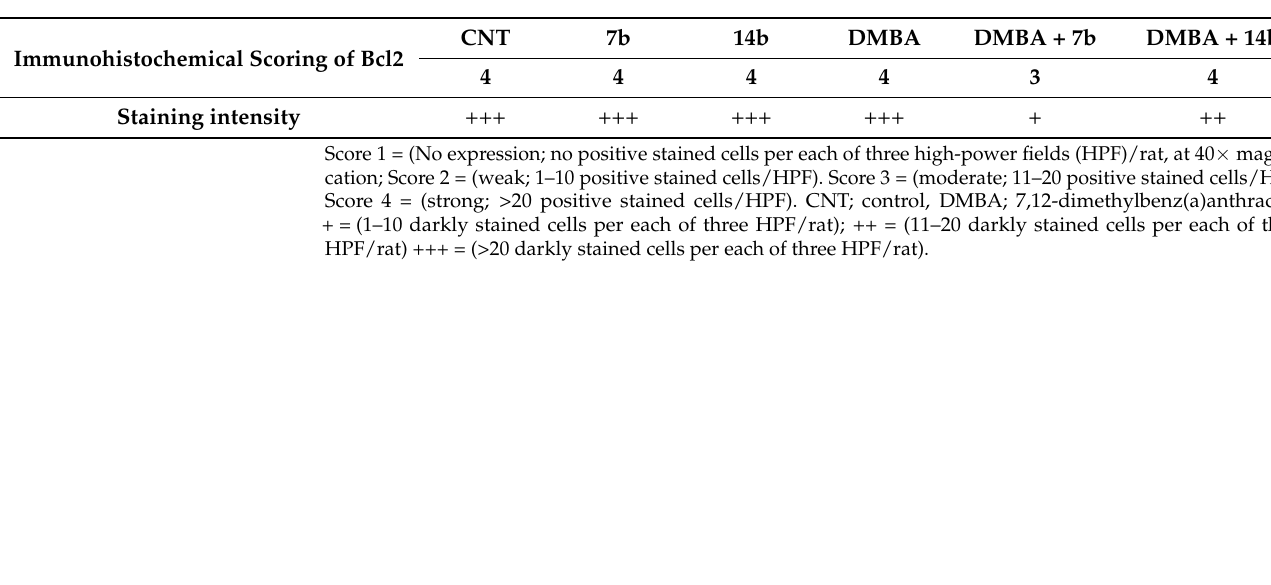
Table 2. Bcl2 immunochemical score and staining intensity in tissue sections of breast tissues of treated